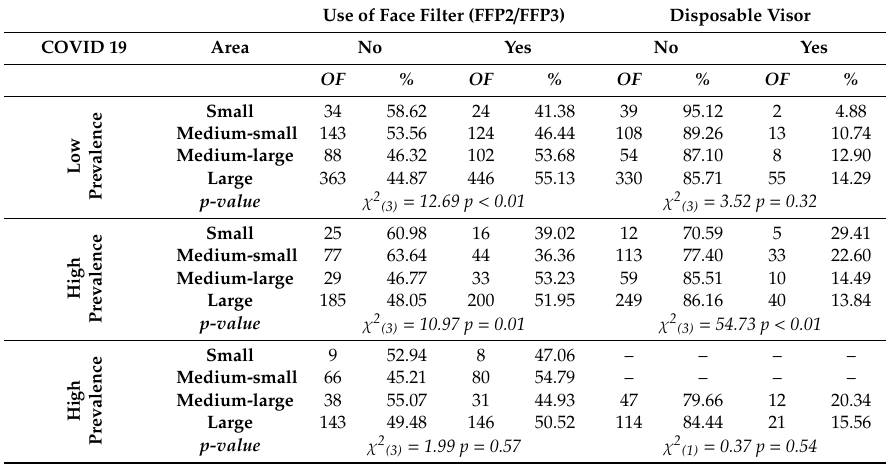
Table 5. Standard protective measures for symptom-free patients since the beginning of the COVID-19 pandemic and stratified by COVID-19 prevalence area and area by size. Percentages were calculated per column.